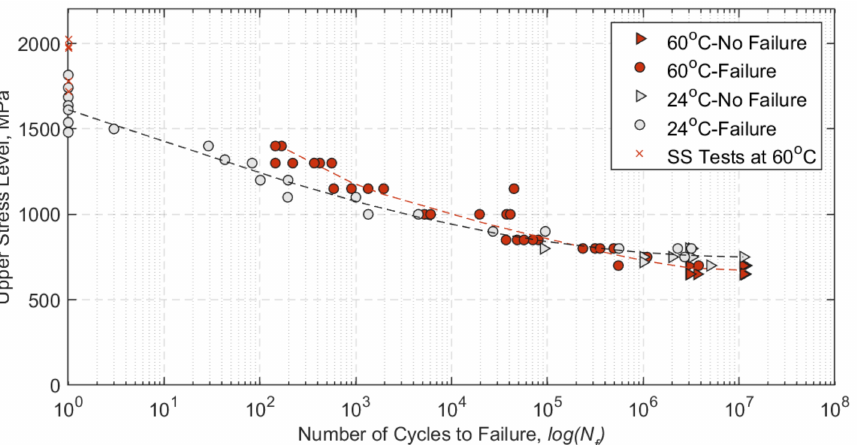
Figure 17. S–N curves with logarithmic best-fit (R2 = 0.93) at 60 ◦ C and at 24 ◦ C (reproduced